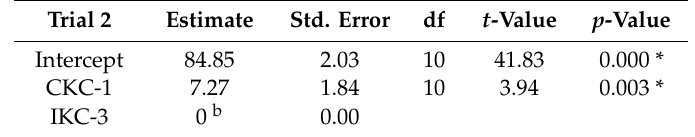
Table 8. The significant di ff erence of mean scores obtained in Trial 1 between CKC-1 and IKC-3. Trial 1 Estimate Std. Error df t -Value p -Value Intercept 81.21 2.55 10 31.81 0.000 * CKC-1 10.00 2.11 10 4.74 0.001 * IKC-3 0 b 0.00